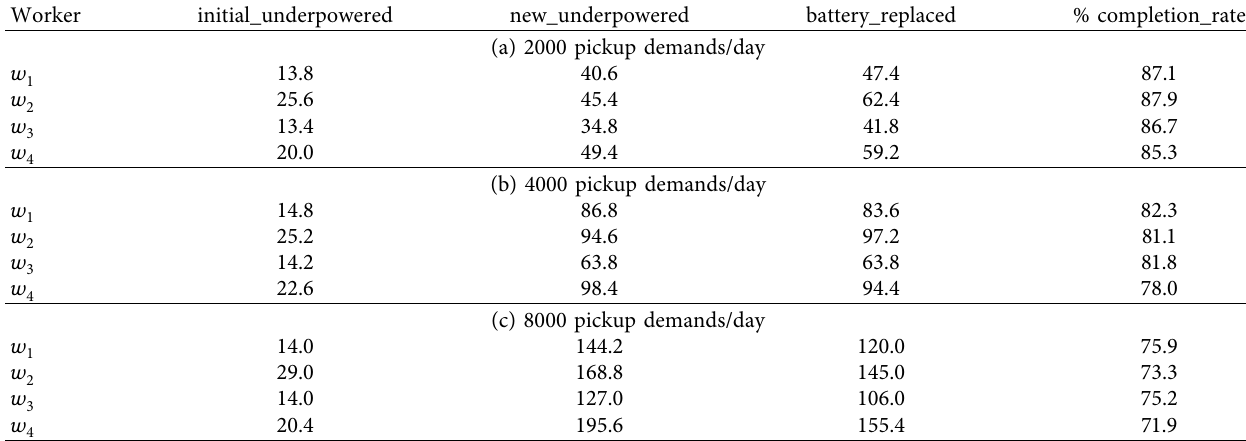
Table 2: Results of the batteries replaced by each worker.